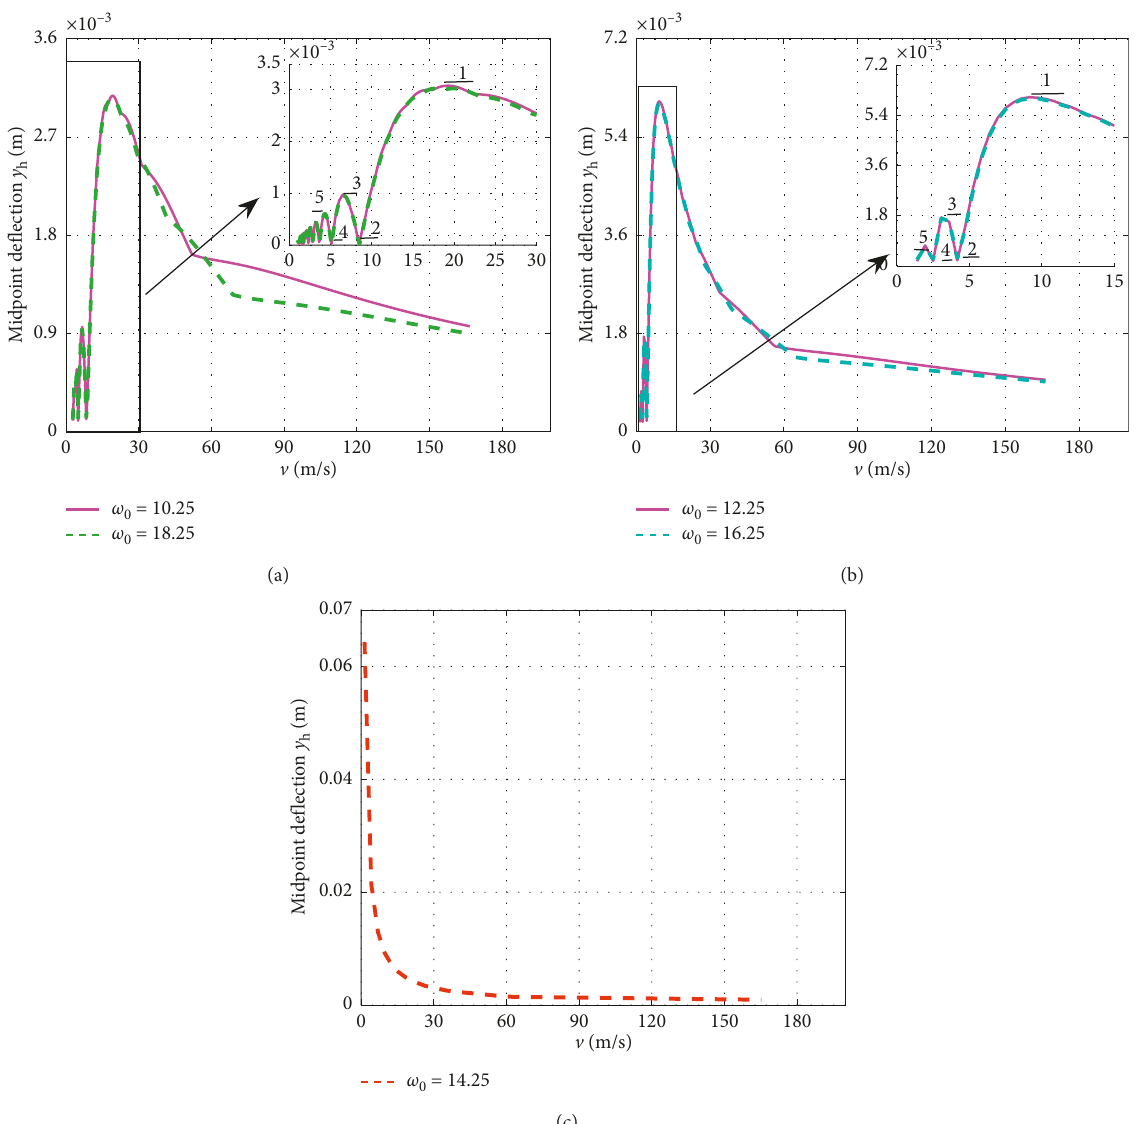
Figure 14: Displacement amplitudes of the bridge free vibration response versus different speeds of the moving load with different Table 5: Speeds of the moving harmonic load with ω sponding to the bridge maximum response. ω (rad/s) 0